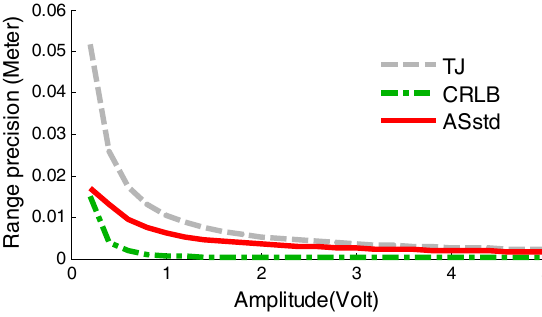
Figure 7. Comparison of ASstd, CRLB and TJ. TJ means the time jitter calculated from Equation (19), CRLB means the Cramer–Rao Lower Bound on range estimated from Equation (11), and ASstd values are the measured range StD calculated based on Section 3.4.